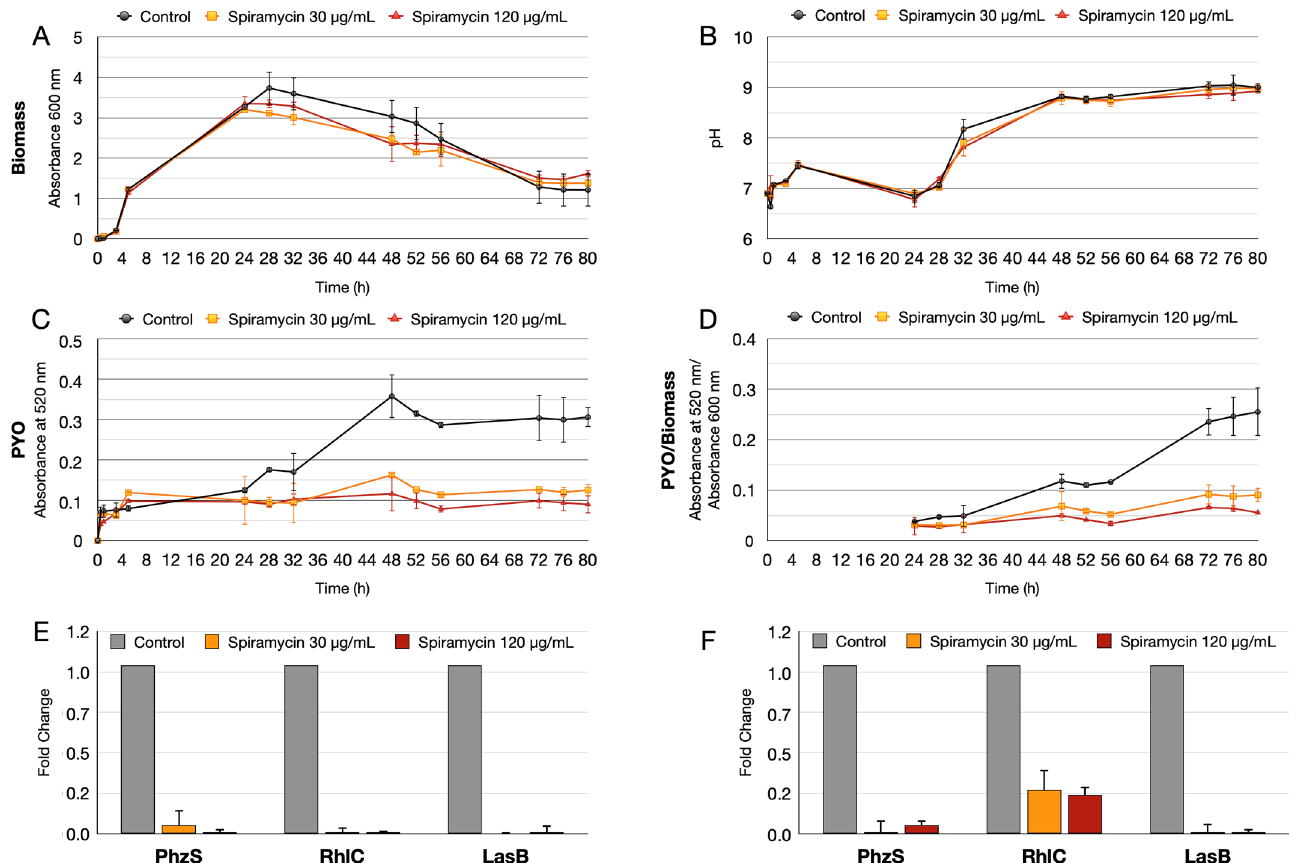
Figure 4. Growth of P. aeruginosa (37 °C and 180 rpm) with and without spiramycin (30 or 120 μ g/mL) and RT-qPCR on phzS , rhlC, and lasB genes. ( A ) Estimation of biomass by turbidity (optical absorbance at 600 nm), ( B ) pH of bacterial cultures, ( C ) estimation of the amount of PYO (optical absorbance at 520 nm). ( D ) Estimation of the amount of PYO (optical absorbance at 520 nm) normalized by the biomass (absorbance at 600 nm). This panel shows data from 24 h onwards when the optical absorbance at 520 is >0.15 in the control sample. ( E , F ) Results of transcript level analysis (RT-qPCR) at 24 h ( E ) and 48 h ( F ) of the phzS (pyocyanin synthesis), rhlC (rhamnolipid synthesis), and lasB (elastase) genes.